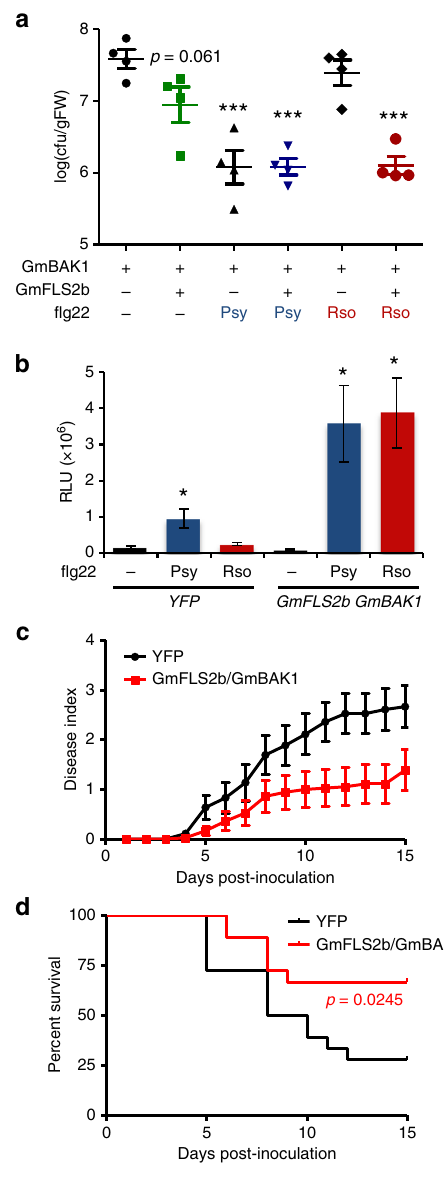
Table 2. All other chemicals were purchased from Sigma-Aldrich unless otherwise stated.